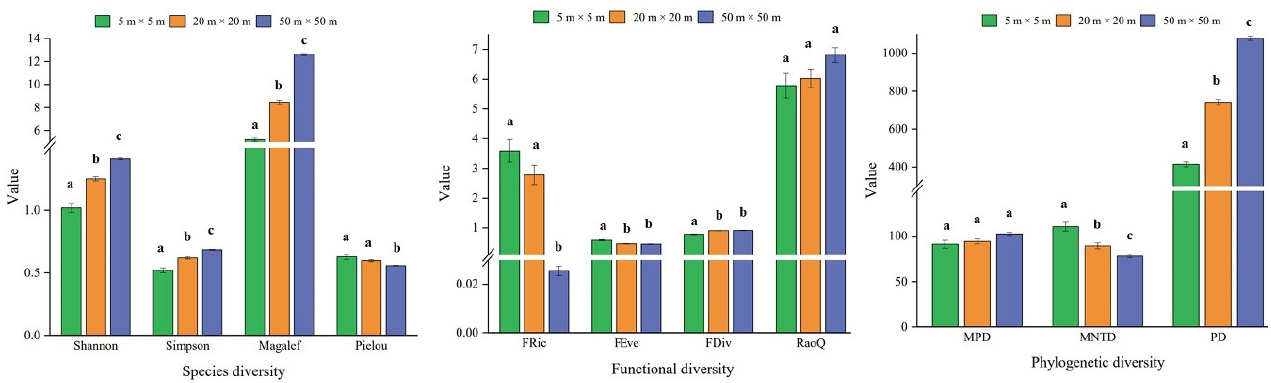
Figure 2. Characteristics and differences in plant diversity between scales (Mean ± SE). Note: error lines are standard errors; different lowercase letters on the error line for the same diversity index indicate highly significant differences between data ( p < 0.05).